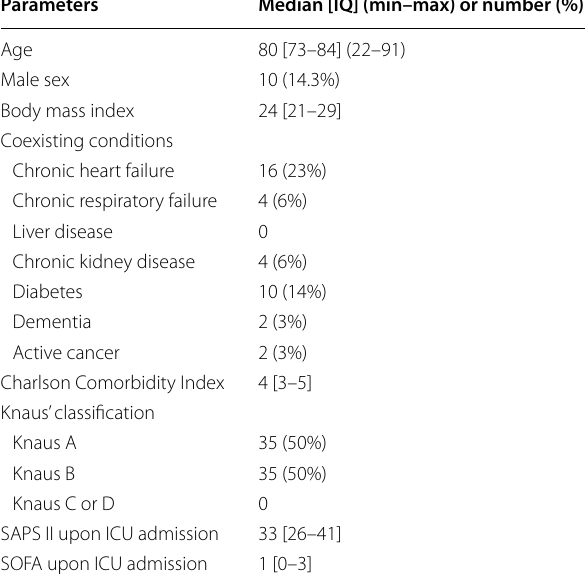
Table 1 Baseline characteristics of patients